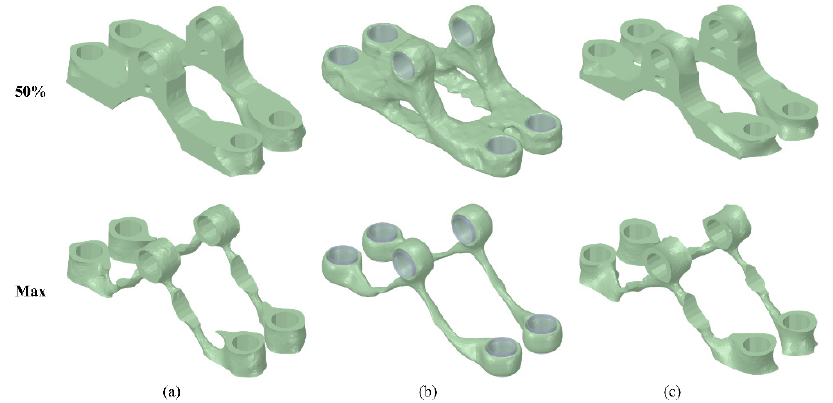
Figure 8. The optimized designs of pillow bracket for 50% and maximum weight reduction in ( a ) SolidWorks, ( b ) ANSYS Mechanical, and ( c ) ABAQUS.